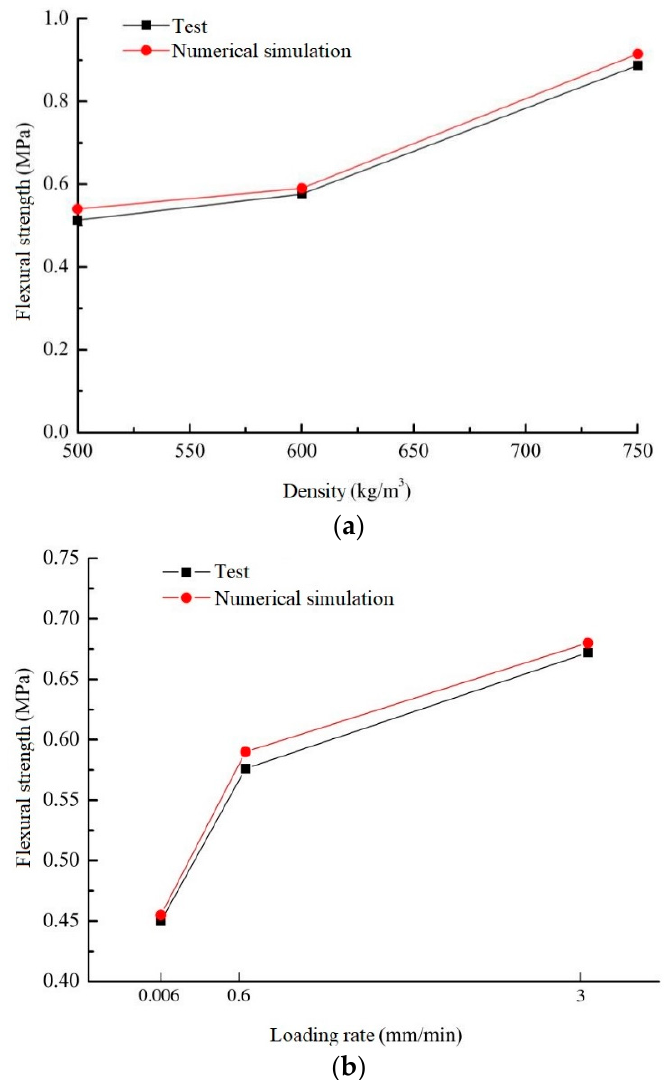
Figure 30. Effect of different densities and loading rates on the flexural strength of the test and numerical simulation results. ( a ) The loading rate is 0.6 mm/min; ( b ) the density is 600 kg/m 3 .